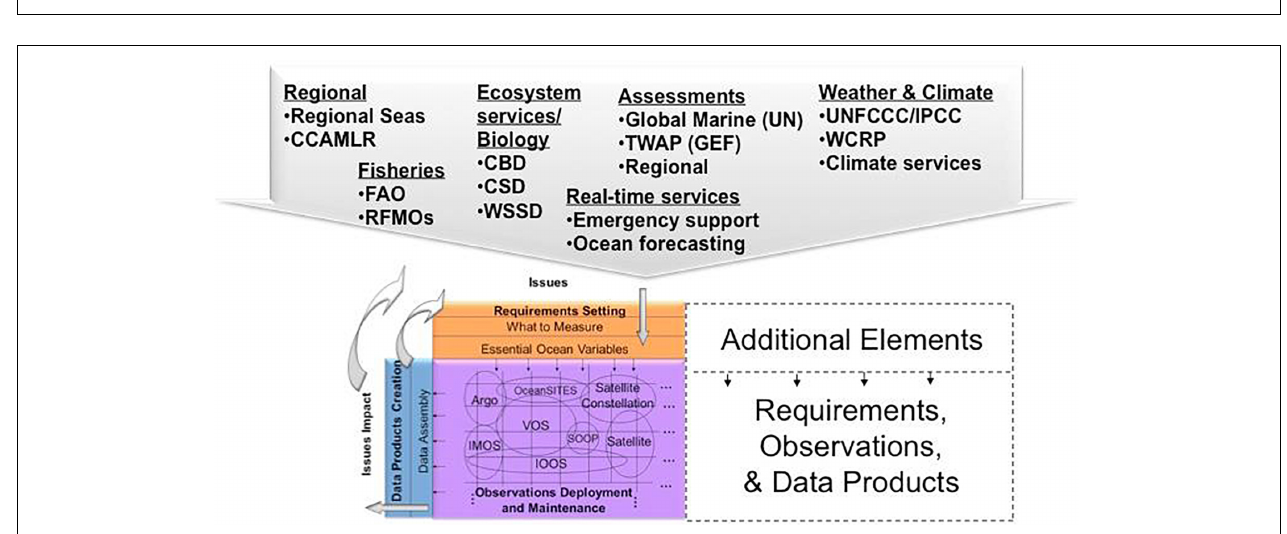
FIGURE 1 | Implementation of GOOS in situ networks versus ‘design’ (IOC-UNESCO, 2018).